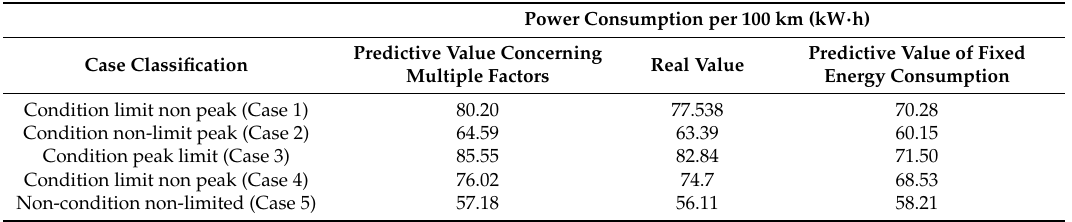
Table 3. Power consumption of 100 km under different circumstances of electric buses.